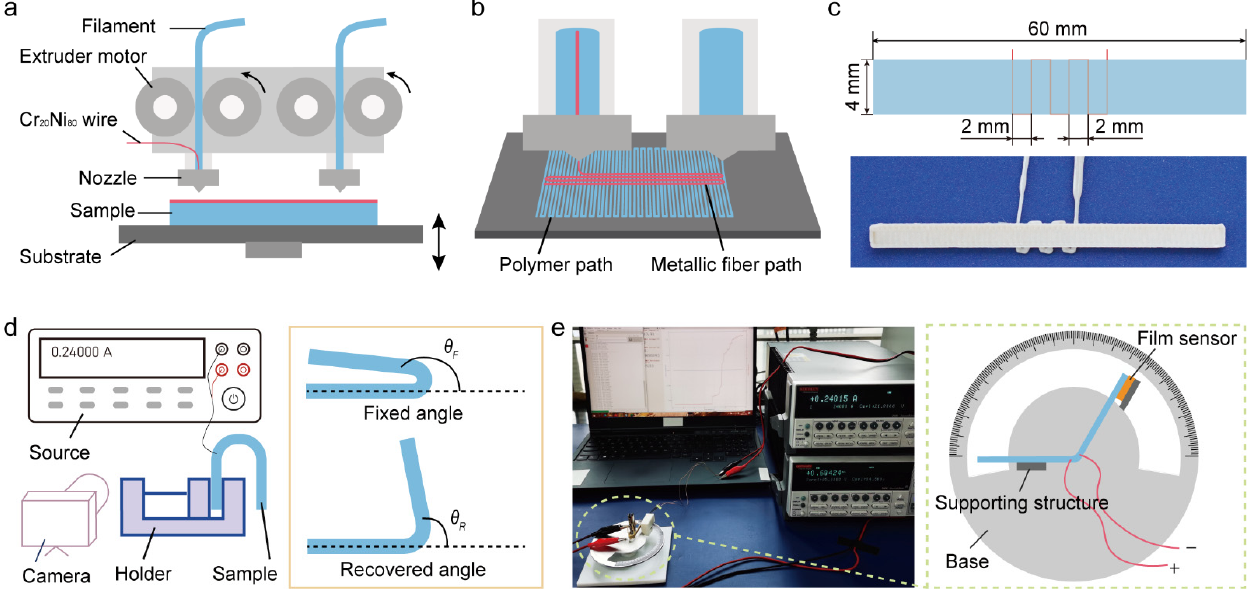
Figure 1. Four-dimensional printing and test method of shape memory PEEK. ( a ) The equipment and construction of 4D printing. ( b ) The process of 4D printing PEEK composites. ( c ) The printed composite sample and sizes. ( d ) The measurement method and definition of angle. θ F was the fixed angle and θ R was the recovered angle between the horizontal line and the free side of the sample. ( e ) The test method and devices of the recovery force.